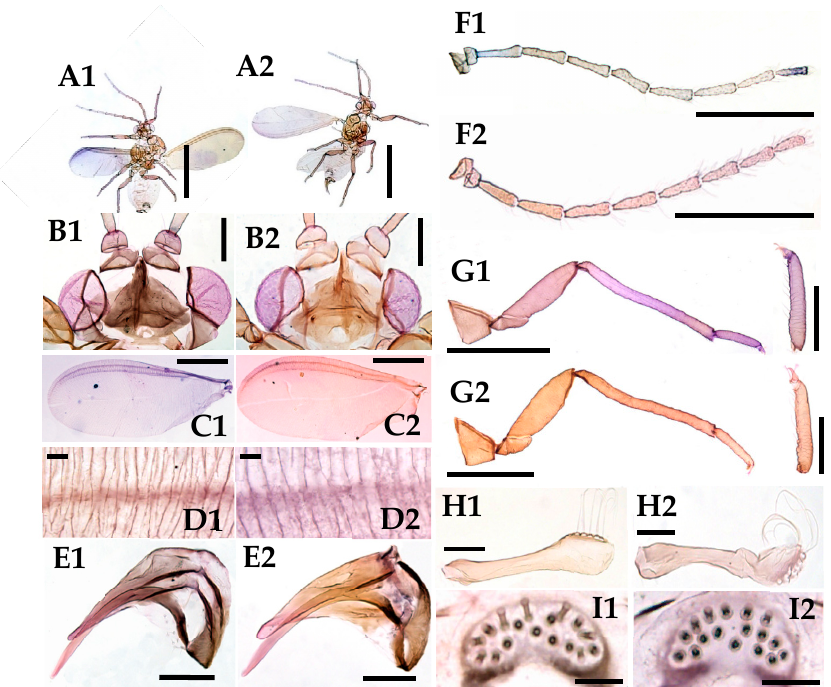
Figure 6. Morphological comparison of the adult males from Goheung (first) and Fukuoka (second). A , bodies; B , heads; C , wings; D , reticulated costal complexes; E , genitalia (aedeagus and penis sheath); F , antennae; G , legs, and tarsi and claws; H , halteres; I , multilocular tubular pores. Scale lines for A = 1 mm; B, E, G (bar beside tarsus and claw) = 100 µ m; C = 0.5 mm; D = 10 µ m; F = 500 µ m; G (bar under entire leg) = 300 µ